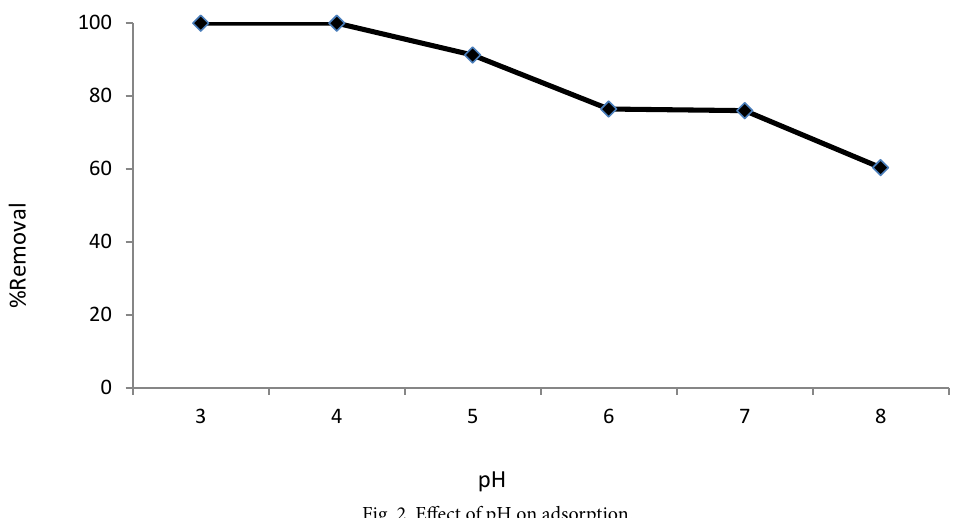
Fig. 2. Effect of pH on